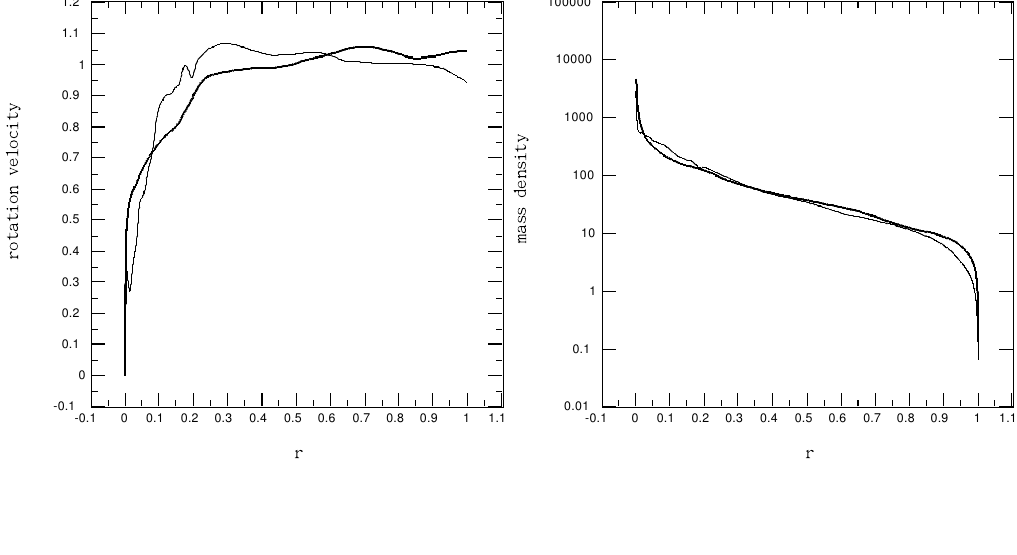
Figure 5. Profiles of NGC 2403 and NGC 3198 rotation velocity V ( r ) and mass density ρ ( r ) , with the thick line for that of NGC 2403 and the thin line for NGC 3198 . The computed values of the galactic rotation number, A , are 1 . 4918 and 1 . 6022 for NGC 2403 and NGC 3198 ,